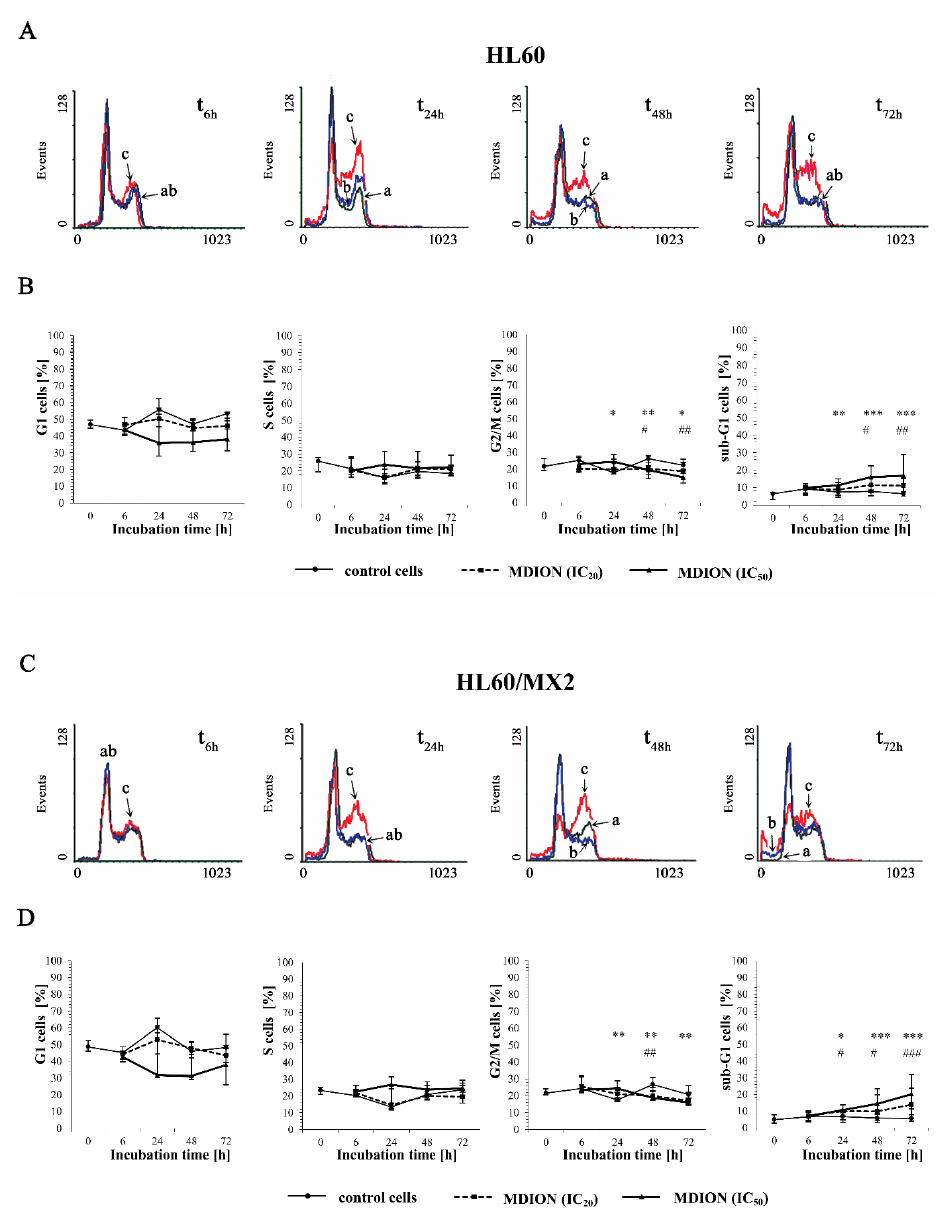
Figure 5. The effect of MDION on the cell cycle distribution in sensitive HL60 ( A , B ) and resistant HL60/MX2 ( C , D ) leukaemia cells and the appearance of subdiploid (sub-G1) cells with degradated DNA. The cells were incubated at 37 °C with MDION used at IC 20 (15.0 µM for HL60 cells and 17.0 µM for HL60/MX2 cells) or at IC 50 (80.5 µM for HL60 cells and 95.5 µM for HL60/MX2 cells), respectively, up to 72 h. The cell cycle distribution was analysed by flow cytometry (FACScan; Becton Dickinson). The red fluorescence (FL-2) of 10 4 events per sample was measured with the use of a laser beam at 585 ± 21 nm ( λ ex = 488 nm) to determine the propidium iodide (PI) labelled DNA content. Presented histograms ( A , C ) are representative examples observed for control and treated cell samples (a, black—control cells; b, blue—cells treated with MDION at IC 20 ; and c, red—cells treated with MDION at IC 50 ). The experiment was repeated at least four times (made in triplicate) and the data are given as median (interquartile range) values ( B , D ). The significance level of the differences observed (Mann–Whitney U test) between values found for cells treated with MDION at IC 20 ( # p < 0.05; ## p < 0.01; ### p < 0.001) or IC 50 (* p < 0.05; ** p < 0.01; *** p < 0.001), respectively, compared with values found for control